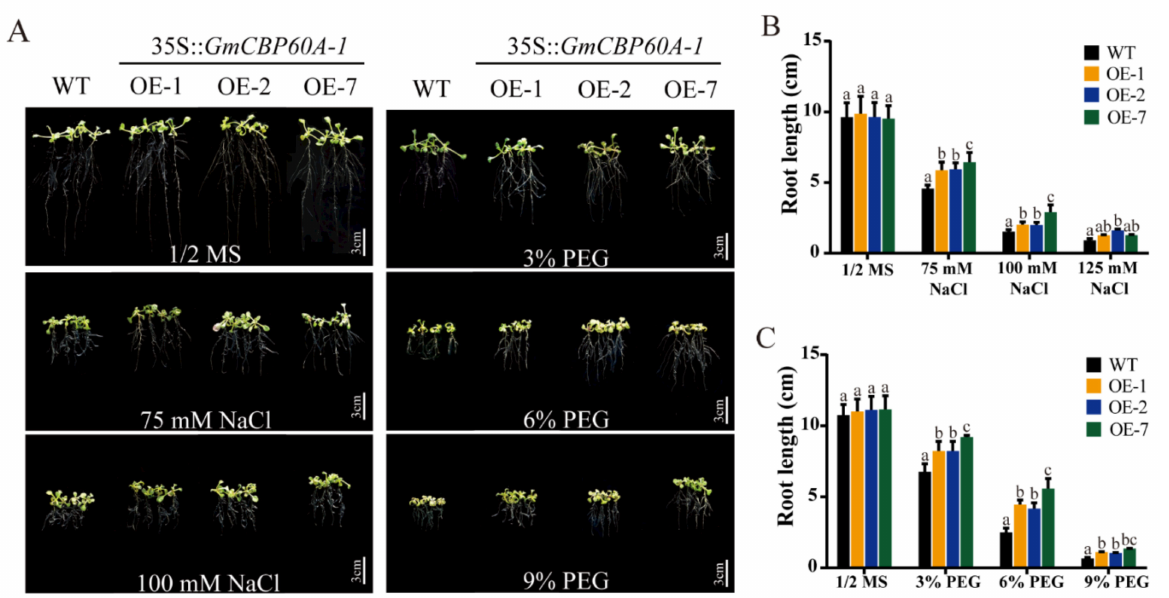
Figure 6. The root growth of transgenic Arabidopsis lines and WT plants under NaCl and PEG treatments and the results of related statistics. ( A ) The seedlings of transgenic lines and WT plants were grown in 1/2 MS, 1/2 MS containing different concentrations of NaCl and 1/2 MS containing different concentrations of PEG6000. ( B ) Root growth variation of transgenic lines and WT in the presence of different concentrations of NaCl. ( C ) Root growth variation of transgenic lines and WT in the presence of different concentrations of PEG6000. Three biological replicates were performed, and the values are means ± SD. Values marked with similar letters indicate not statistically significant differences (Student’s t -test: p ≤